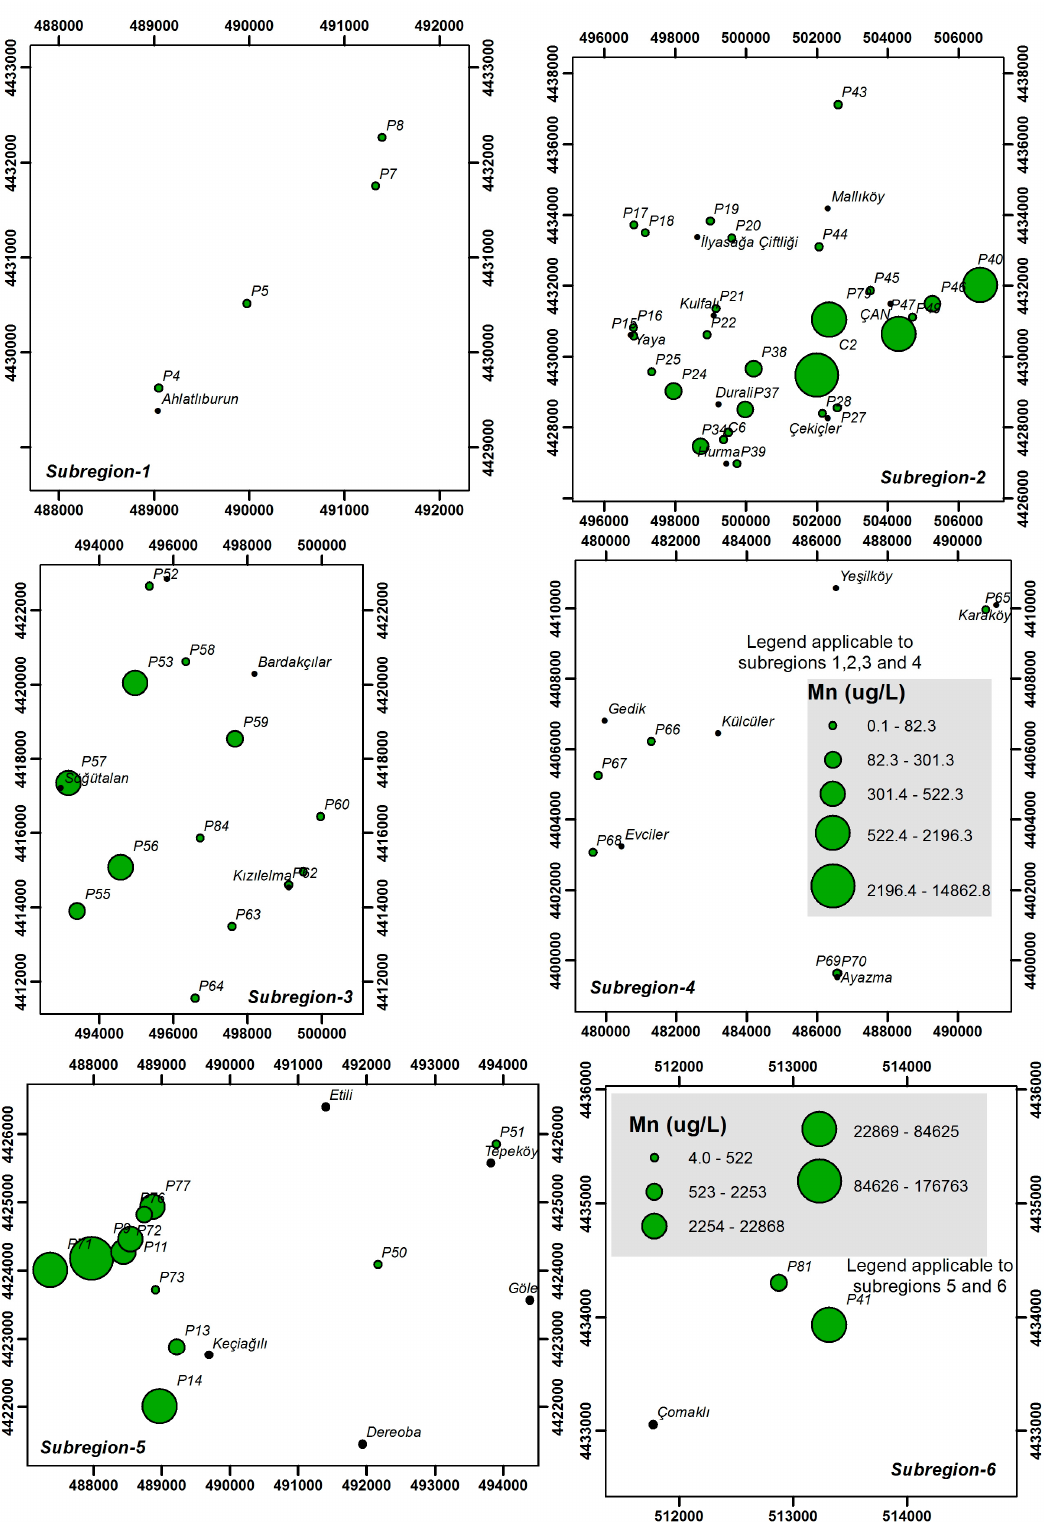
Figure 10. Spatial distribution of manganese.